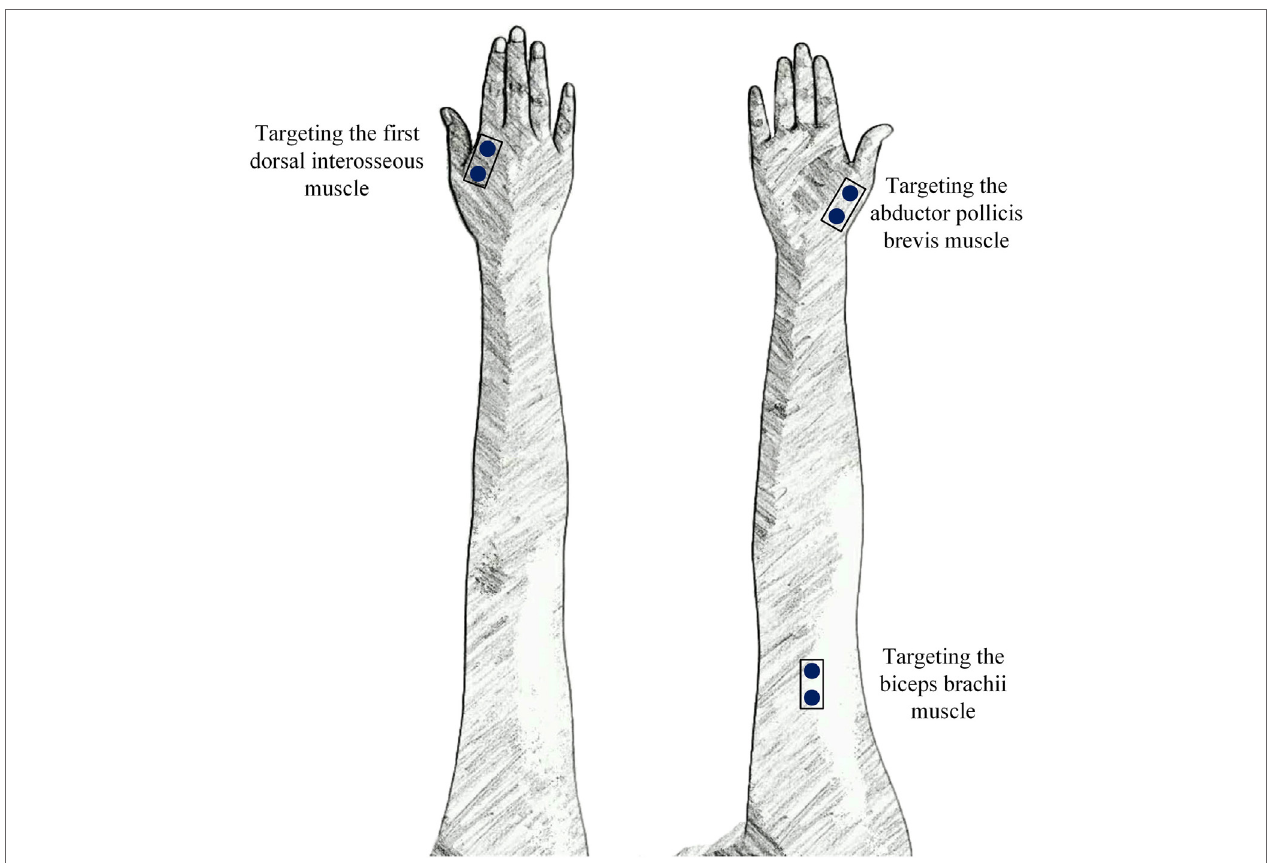
FigUre 1 | The placement of three surface electromyogram (EMG) sensors that targeted three muscles in each arm.